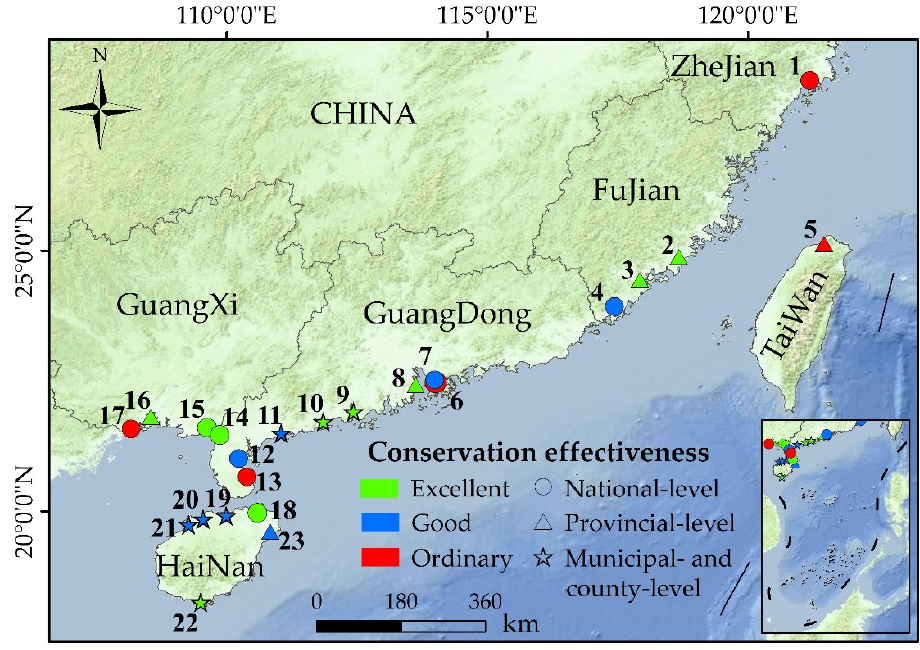
Figure 2. Evaluation results of conservation effectiveness of reserves in different